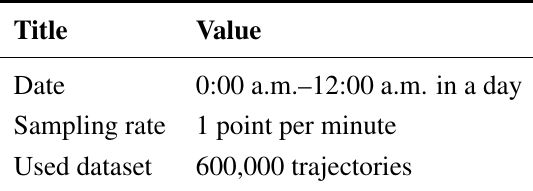
Table 1. PFLOWdataset